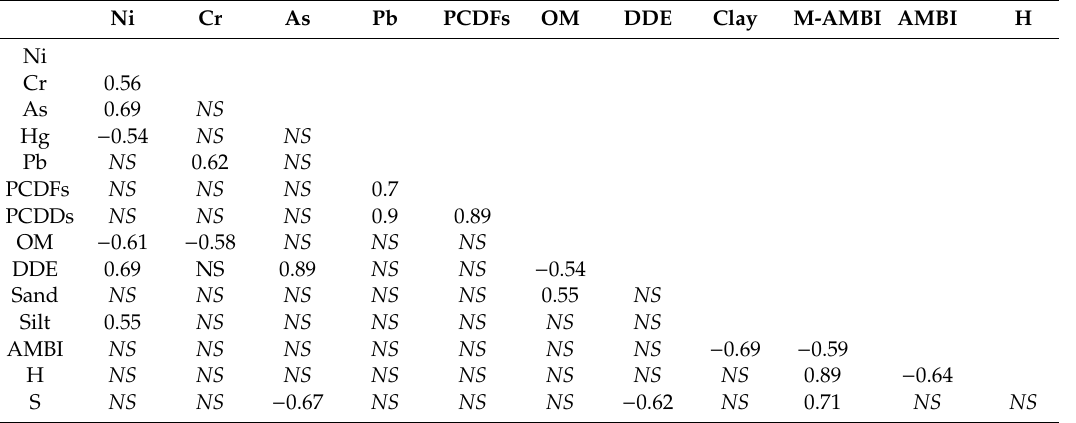
Table 4. Collinearity (r s ) among abiotic and biotic variables (n = 3). Only variables showing significant correlations were displayed. NS = p >